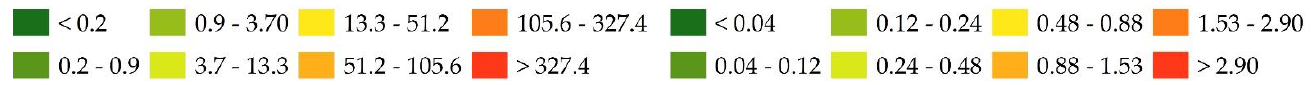
Figure 7. Modeled wildfire exposure to natural sites regarding the burned area ( A ) and the percentage burned area ( B ) per year in Portugal. The total burned area in protected natural sites is 18,257 ha per year. The protected natural sites included national parks, nature reserves, protected landscapes, and natural monuments described in the Decree-Law 142/2008 and Natura 2000 network (92/43/EEC).